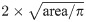
Organoid data distributions.(A) Distribution of the number of manual segmentation boundary points per organoid. (B) Distribution of organoid effective diameter, defined as 2×area/π.